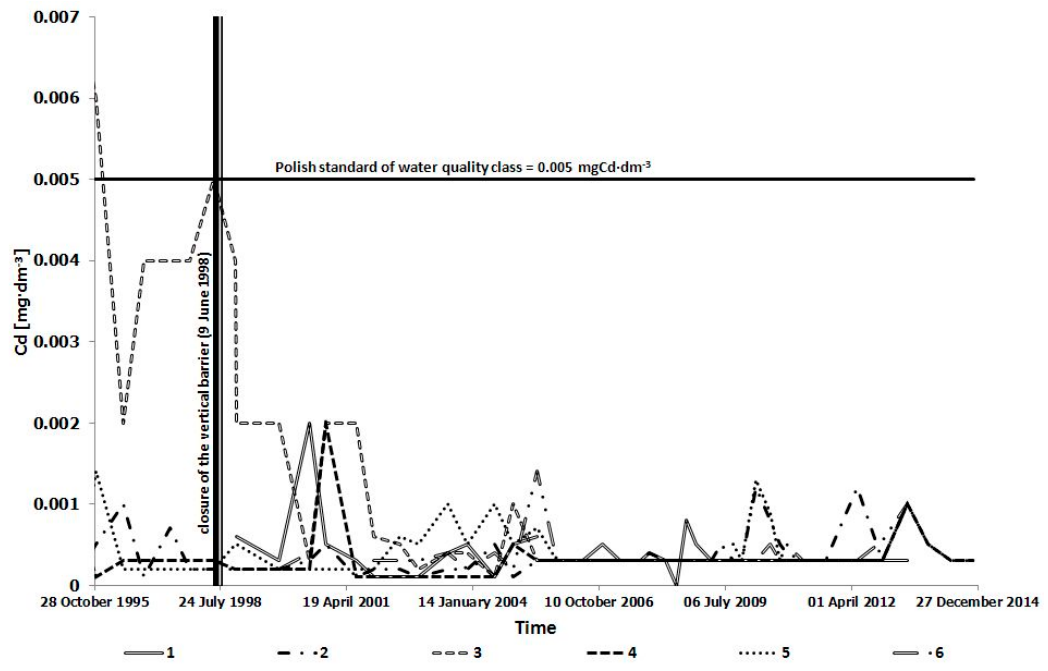
Figure 4. Changes of cadmium concentration in groundwater on MSW Łubna Landfill surroundings during monitoring period 1994–2014.